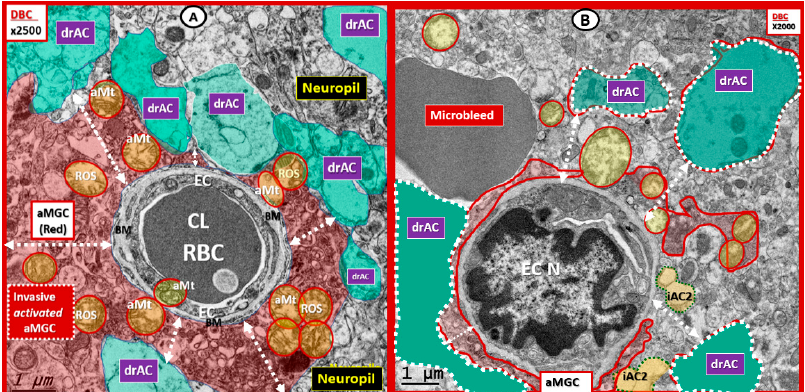
Figure 7. The separation, detachment, and retraction of astrocyte end-feet foot processes (ACfp) in female diabetic DBC with a loss in the connectivity to regional neurons: ( A and B ) Representative images of the neurovascular units (NVU) with ACfp–drAC (detached, retracted, and separated) (pseudo-colored cyan). Both images depict a basement-membrane (BM) thickening with aberrant mitochondria (aMt) pseudo-colored yellow with encircling red lines. Incidentally, aMt may be a source of reactive oxygen species (ROS). Note the invading activated MGCs (aMGC) (pseudo-colored red). In Figure 7A, the activated microglia (aMGC) has totally encompassed the NVU, while in Figure 7B, it has not quite completely undergone total invasion. Note the white dashed double arrows in each image denoting these separations of the drACs (ranging from 0.2 to 2 micrometers) from the NVU BMs. These separations of ACfp–drACs could definitely interrupt and result in a loss of neurovascular coupling with regional neurons resulting in an impaired cerebral blood flow with ischemia and hypometabolism to regional neurons. Additionally, this separation of ACfp–drAC from NVU could result in an impaired cellular crosstalk between regional neurons and their NVUs in addition to the separation of the drAC crosstalk with vascular mural cells and could result in an increased permeability. aMGC = activated microglia cell; aMt = aberrant mitochondria; Cl = capillary lumen; EC N = endothelial cell nucleus; drAC = detached astrocyte; RBC = red blood cell; Available via license CC BY